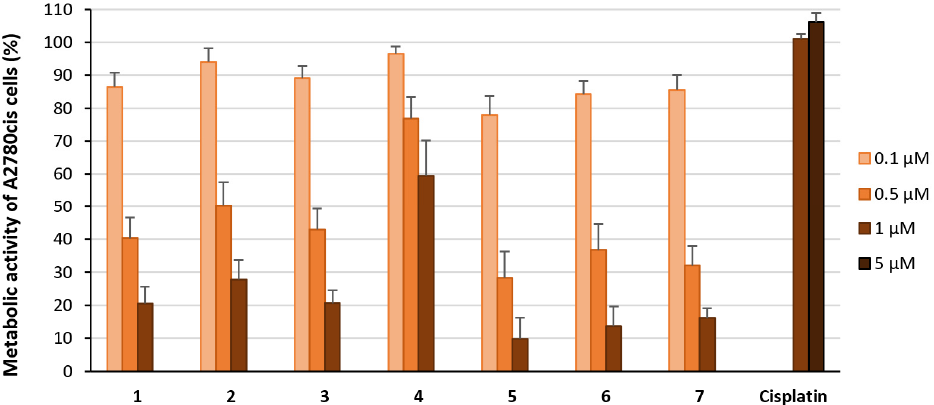
Figure 2. Metabolic activity of A2780cis cells treated with the complexes 1 – 7 at concentrations of 0.1 µ M (light orange), 0.5 µ M (orange), and 1 µ M (light brown) for 72 h. Metabolic activity in the absence of the compounds was set at 100%. Data are expressed as mean + SE of six experiments. Cisplatin was used as a reference at concentrations of 1 µ M and 5 µ M (dark brown).